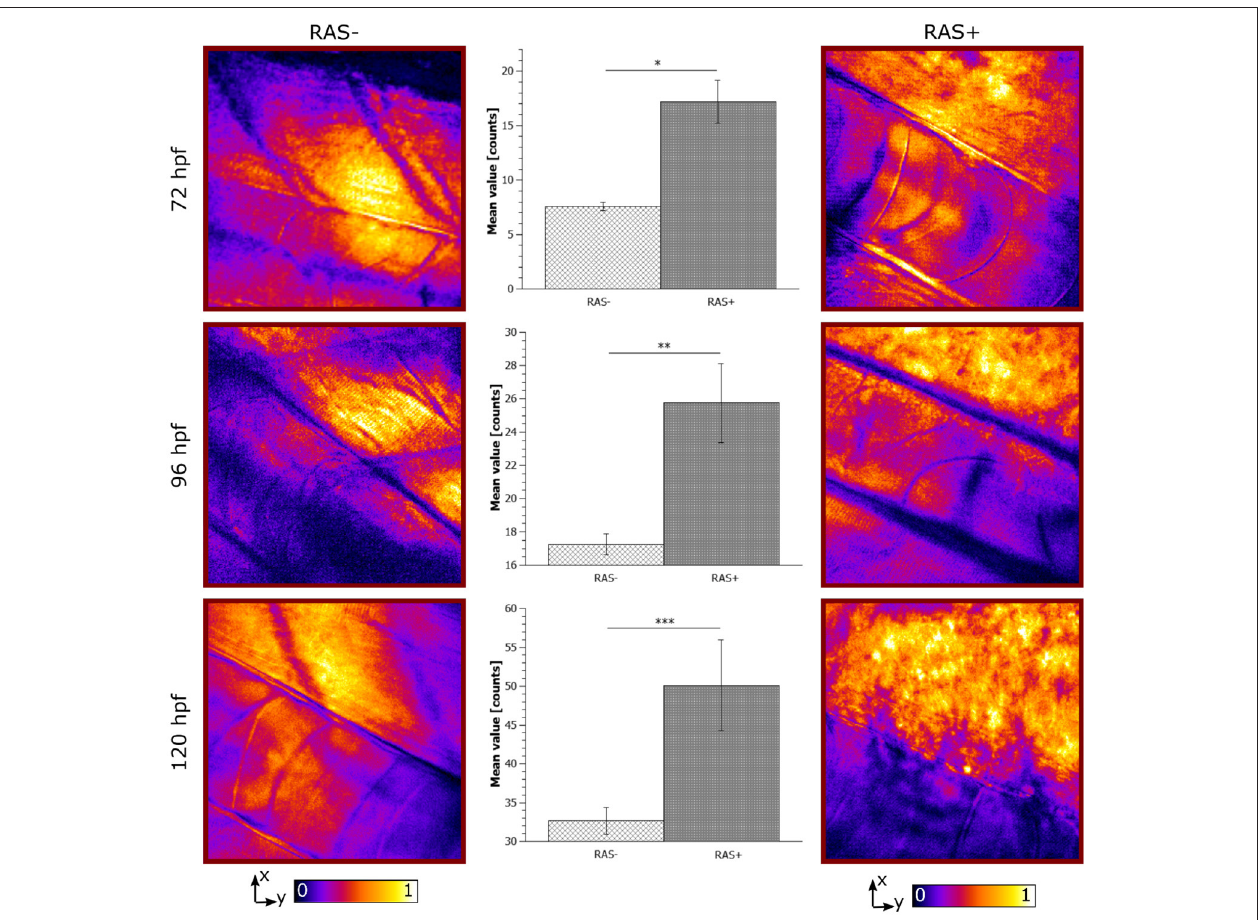
FIGURE 5 | Longitudinal in vivo coherent anti-Stokes Raman scattering (CARS) images at 2,845 cm − 1 for RAS- and RAS+ larvae from 72 to 120 hpf (left and right columns). All images have a field of view (FOV) of 100 × 100 µ m 2 . The single image contrast is optimized for better visualization. Center column shows the lipid distribution on the specific region of interest (ROI). Significant differences between the 3 groups with n = 3 (72, 96, and 120 hpf) are shown (* p < 0.02, ** p < 0.03, and *** p <